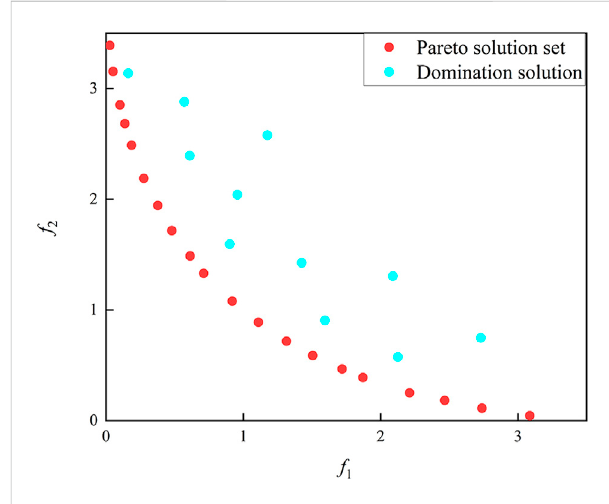
FIGURE 5 Distribution of bi-objective Pareto solution